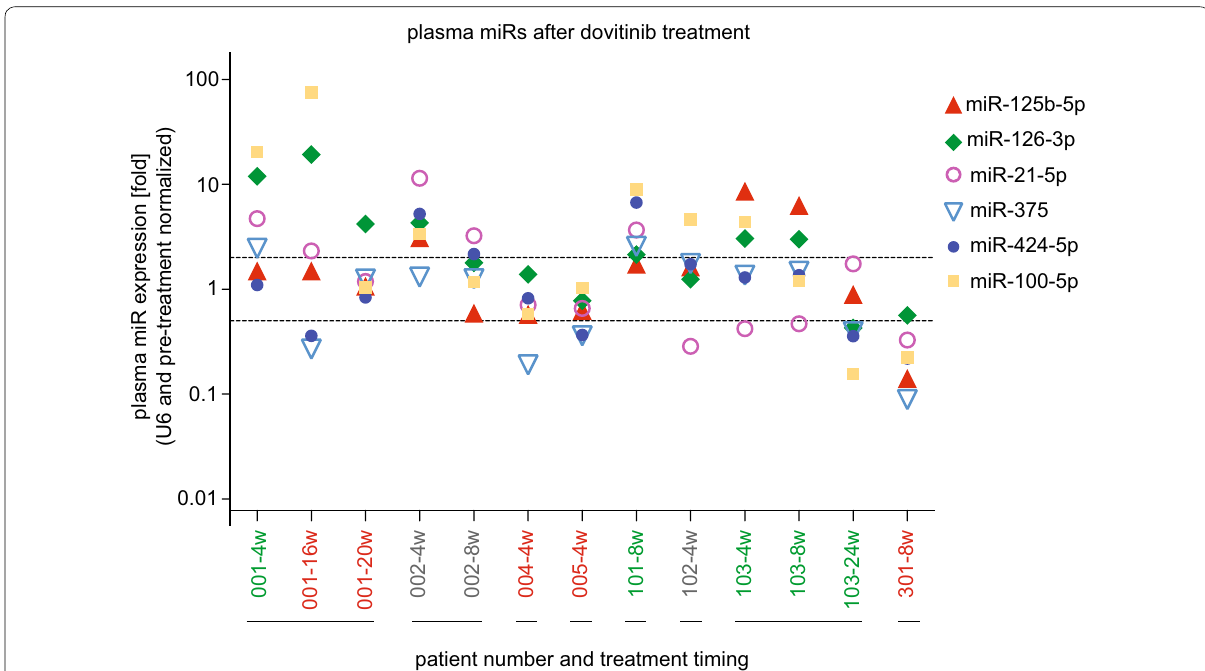
Fig. 2 Effect of dovitinib treatment on plasma miR levels of patients with metastatic breast cancer. MiRs were measured in plasma samples of patients collected before and after dovitinib treatment. The change in expression levels of six miRs relative to U6 in 8 patients at different treatment times (in weeks; w) is shown. The dashed lines indicate twofold up- or down-regulation of miR expression levels after treatment. The numbers on the x-axis indicate the patients. The color code of patients indicates changes in tumor sizes during treatment (red grey no =